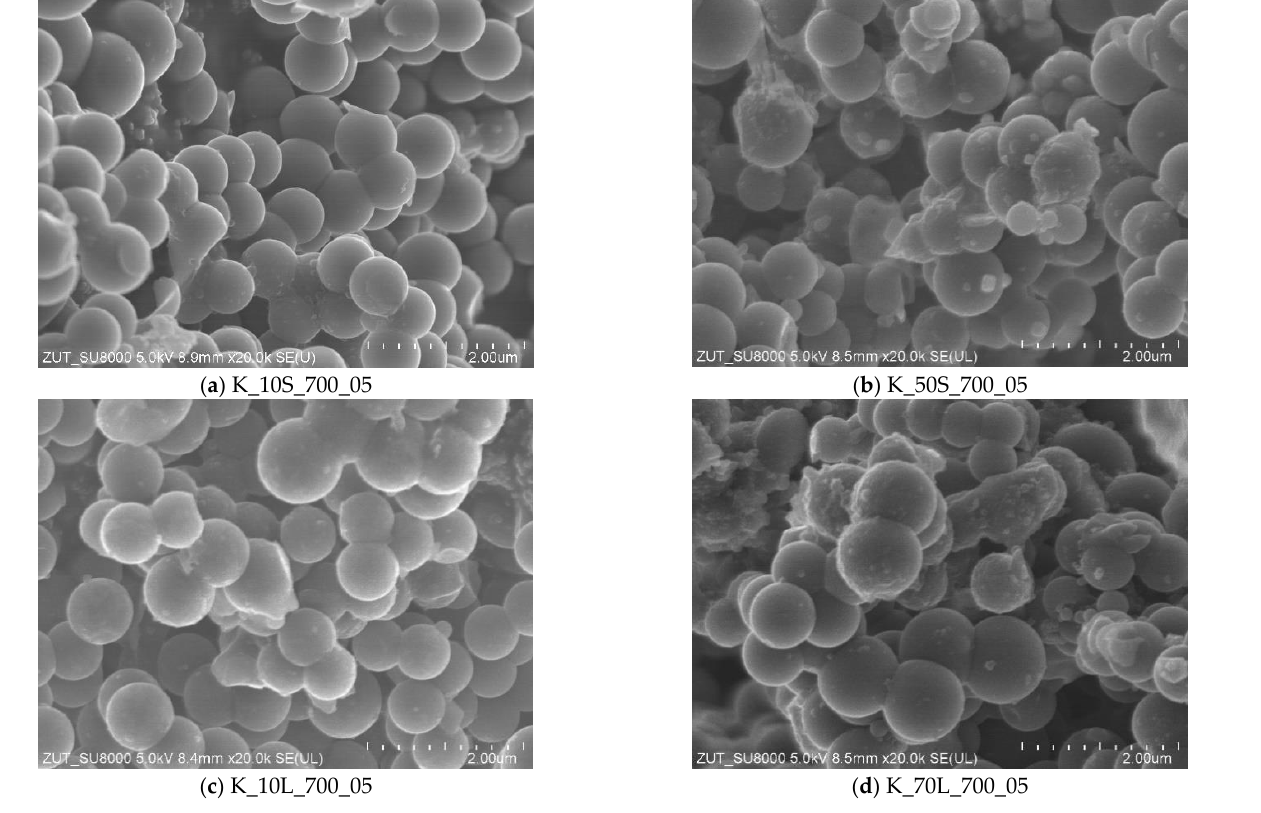
Figure 1. SEM images of the samples activated using a solid-based method with KOH content of 10 wt.% ( a ) and 50 wt.% ( b ) or a solution-based method with KOH content of 10 wt.% ( c ) and 70 wt.% ( d ).